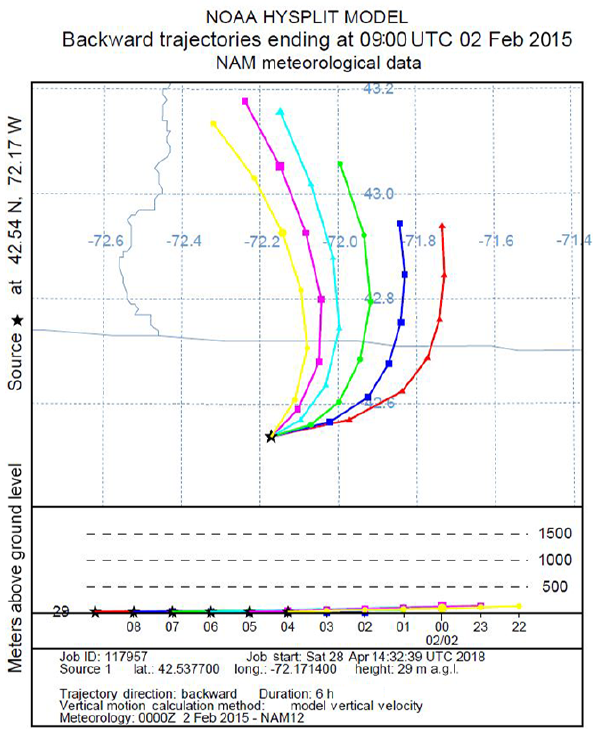
Figure 7. An example of 6h back-trajectories for Harvard Forest on 2 February 2015. Trajectories start hourly between 22:00 and 04:00EST, corresponding to the nighttime interval for slope plots. State lines for New Hampshire, Vermont, and Massachusetts are in gray. On this particular night, the source region was fairly constant, so changes in O 2 and CO 2 are relatively likely to be primarily due to local